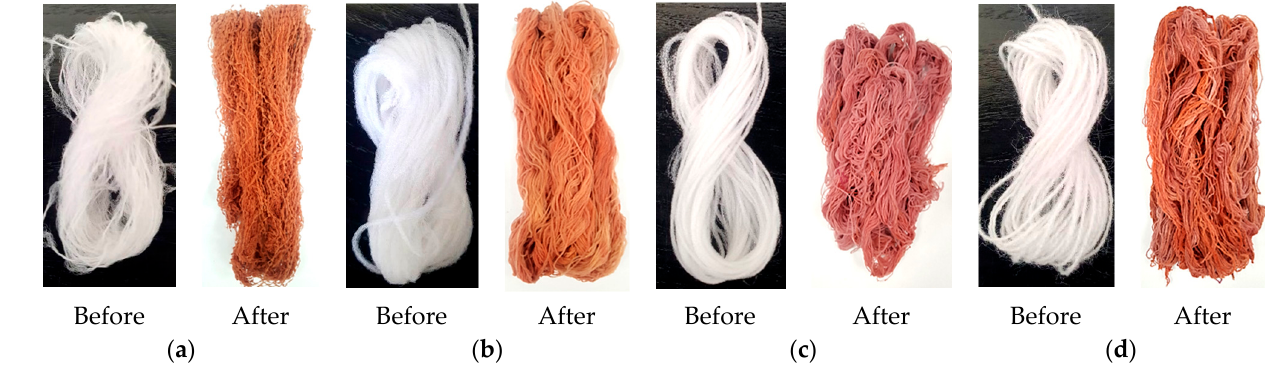
Figure 2. Examples of synthetic fibers after the first stage of selenium: ( a ) PA6, ( b ) PA66, ( c ) PAN, and ( d ) PES.